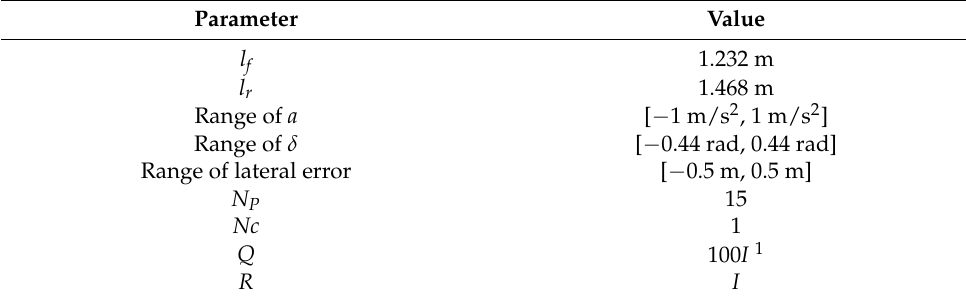
Table 1. Parameters of the vehicle and the